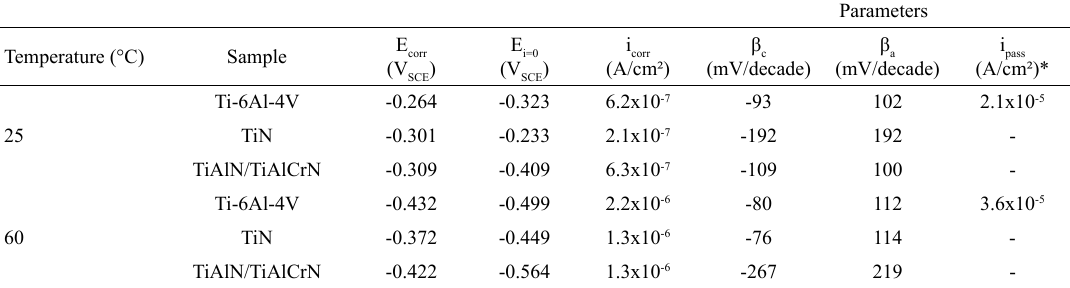
Table 1. Open circuit potential and polarization electrochemical parameters of uncoated, TiN and TiAlN/TiAlCrN coated Ti-6Al-4V alloy measured in at 25 and 60°C.